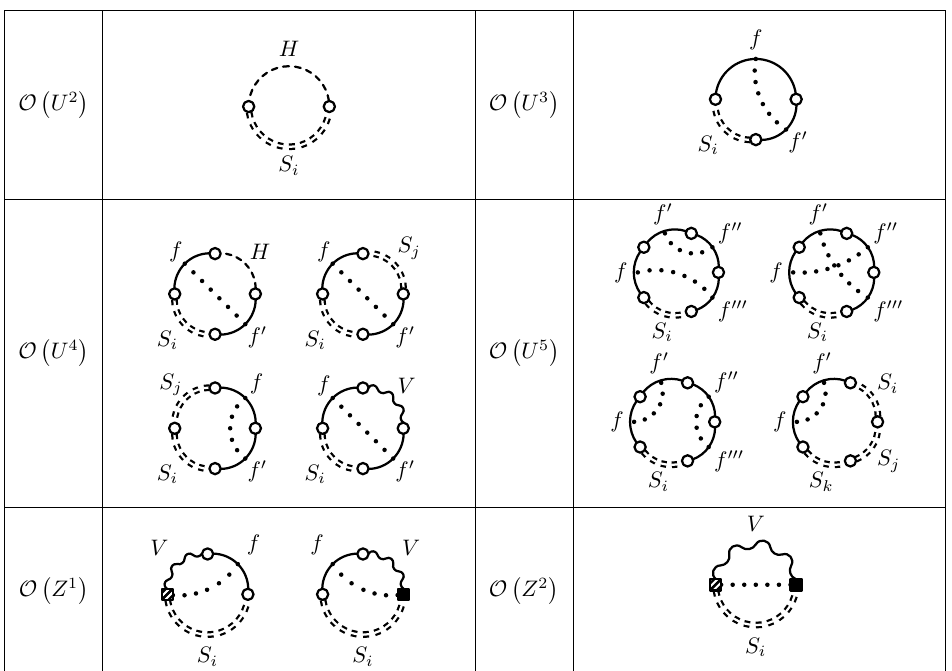
Table 4 . U and Z only, heavy-light, covariant diagrams contributing to the construction of opera- tors up to dimension 6. Where S